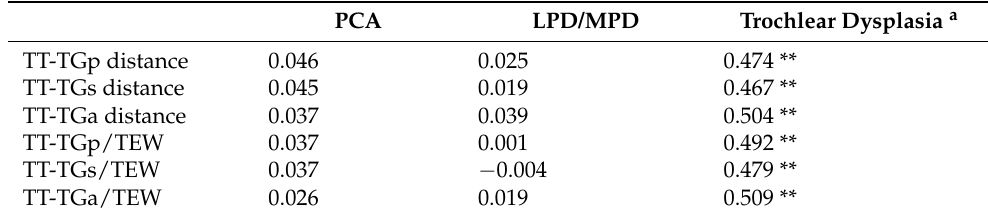
Table 3. The correlations between TT-TG distance parameters and the measurements of femoral condylar morphology, showing the r and ρ value.